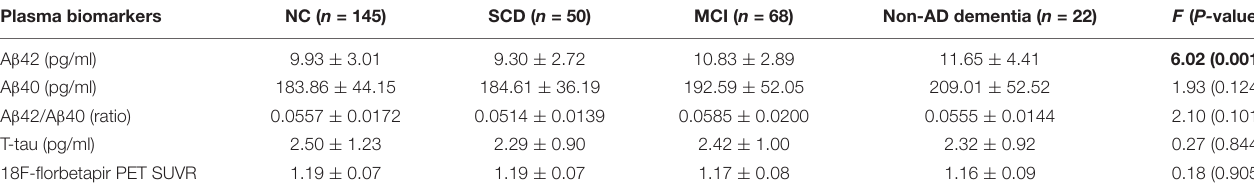
FIGURE 1 | Pairwise comparisons of plasma A β 42, A β 40, and A β 42/A β 40 among NC, SCD, MCI, and non-AD dementia with A β -PET (–). P -values were adjusted for age, sex, and education years. The black circles represented the outliers. TABLE 2 | Plasma A β 42, A β 40, A β 42/A β 40, t-tau, and 18F-florbetapir PET SUVR for NC, SCD, MCI, and non-AD dementia in individuals with A β -PET ( − ). Plasma biomarkers NC ( n = 145) SCD ( n = 50) MCI ( n = 68) Non-AD dementia ( n =